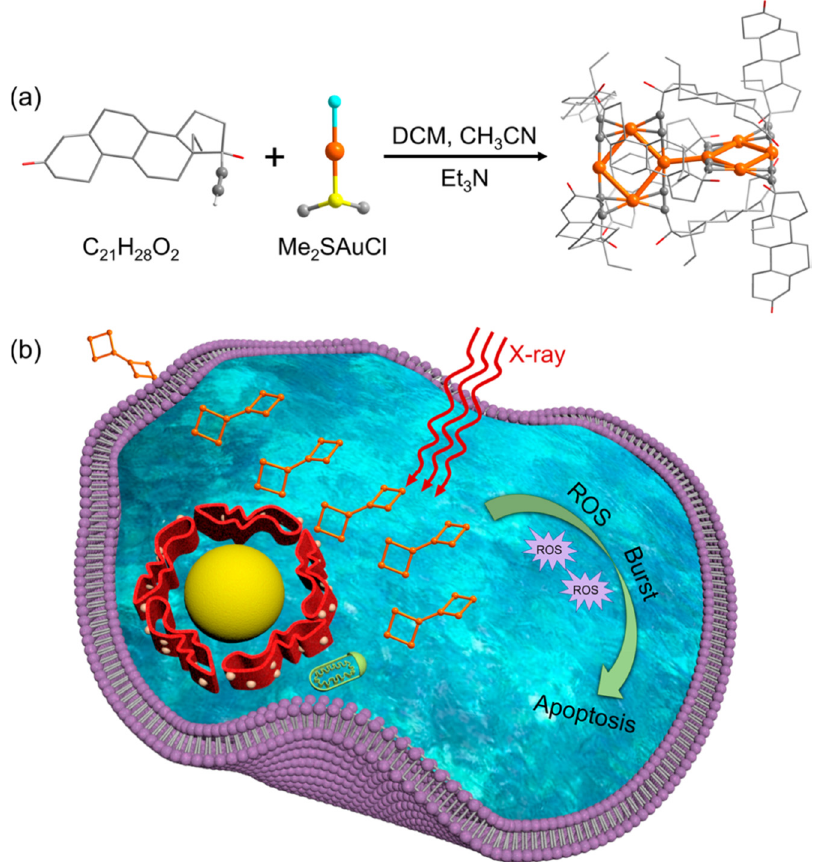
Scheme 2. ( a ) The synthetic scheme of Au 8 NCs; color code: orange—Au, red—O, yellow—S, turquoise—Cl, gray—C. Hydrogen atoms are omitted for clarity. ( b ) Au 8 NCs for cancer radiotherapy.